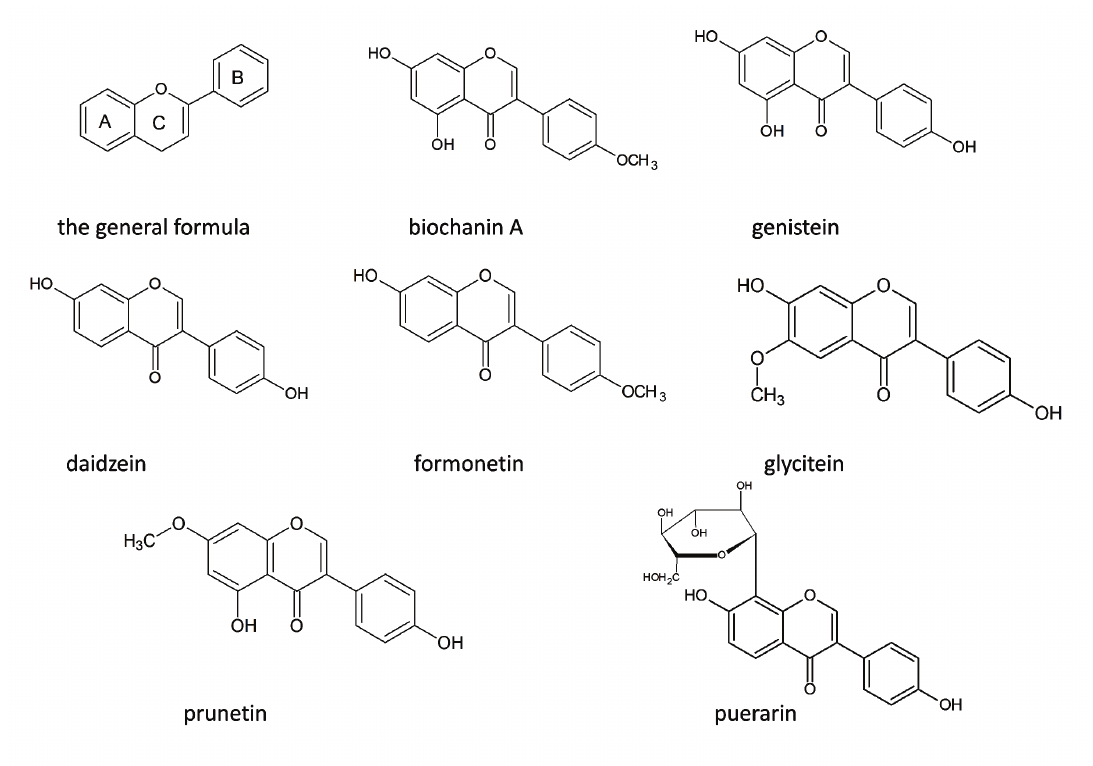
Figure 1: The structural formulas of some of the